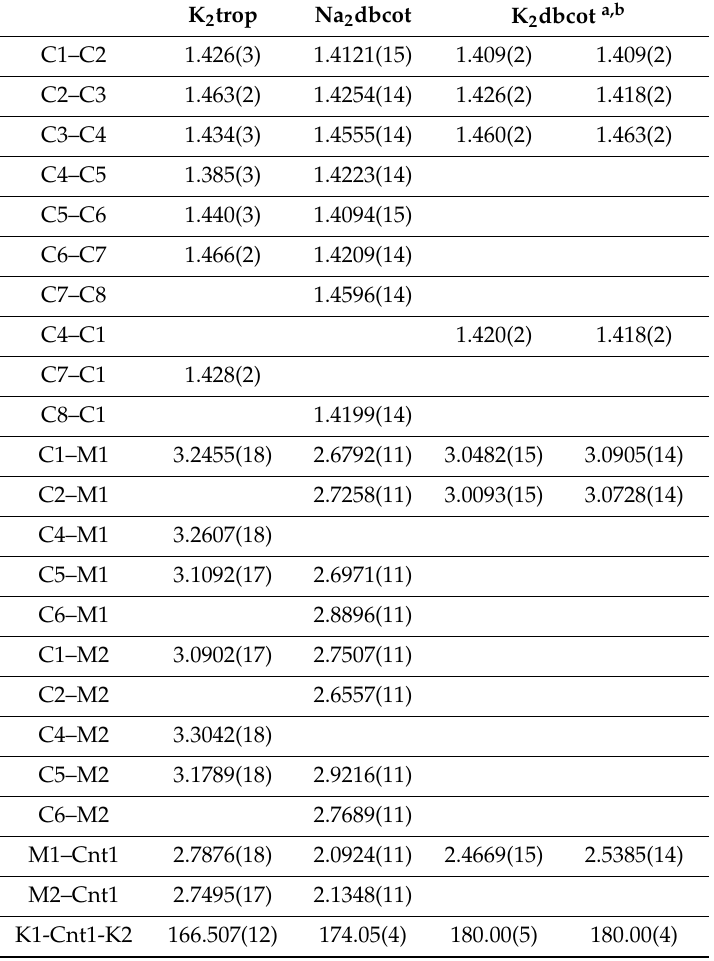
Table 4. Selected bond lengths (Å) for ion pairs containing the trop 2- and dbcot 2- dianions (Figure 2). Abbreviation: Cnt: